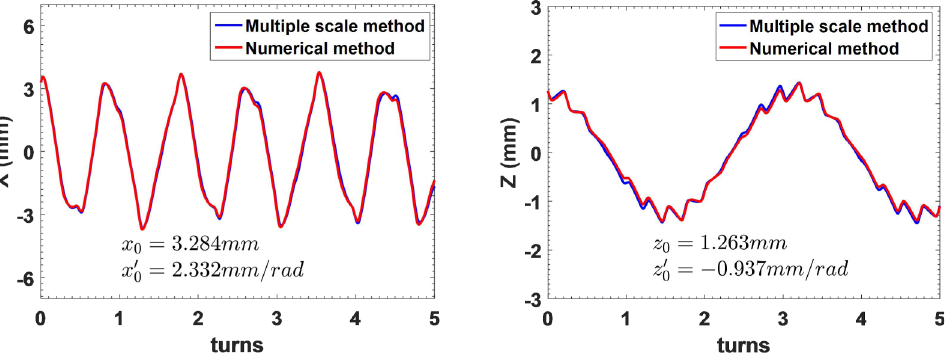
oscillation.FIG. 3. Transverse oscillations obtained from the numerical method (red) and analytical solutions (blue) for a 100 MeV particle: (left) radial oscillation and (right) vertical